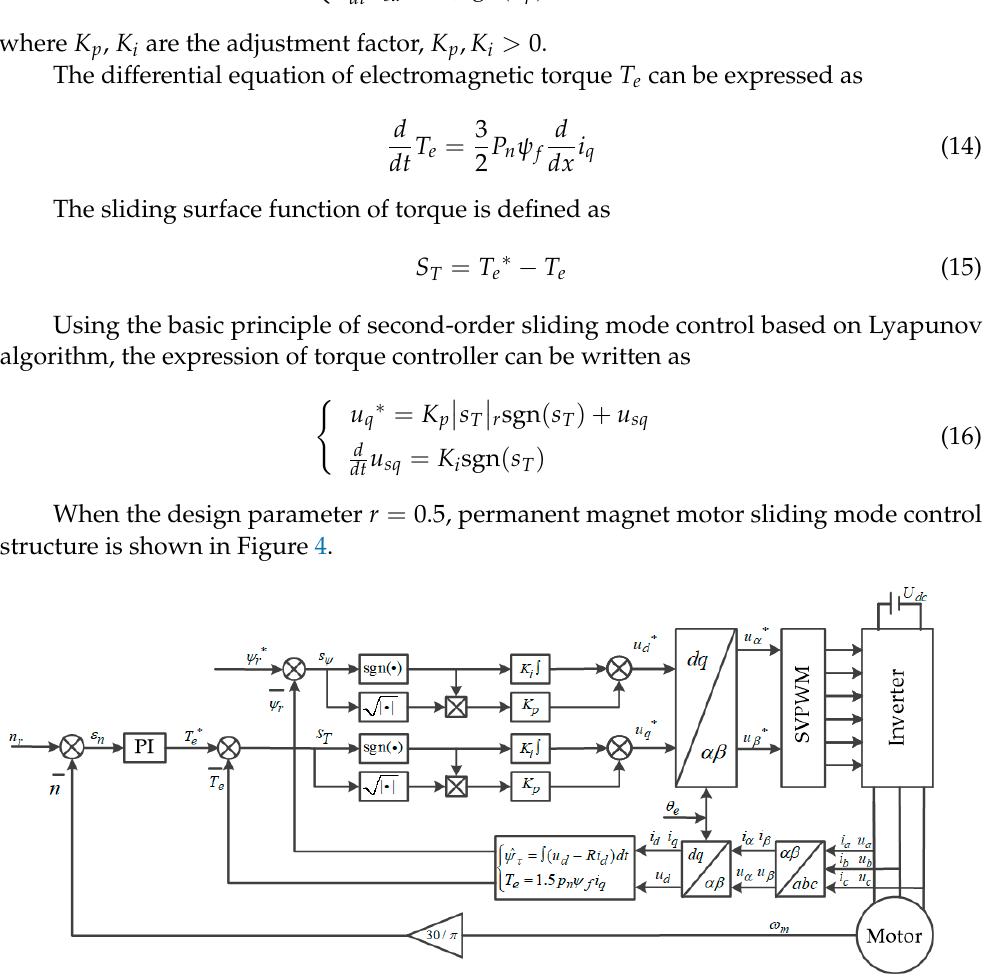
Figure 4. Direct torque controller block diagram based on double sliding mode control.